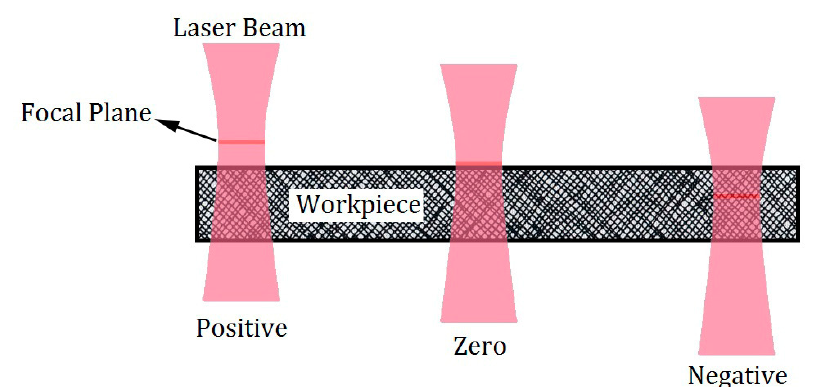
Figure 1. Alteration of figure plan position (FPP) on the sheet.